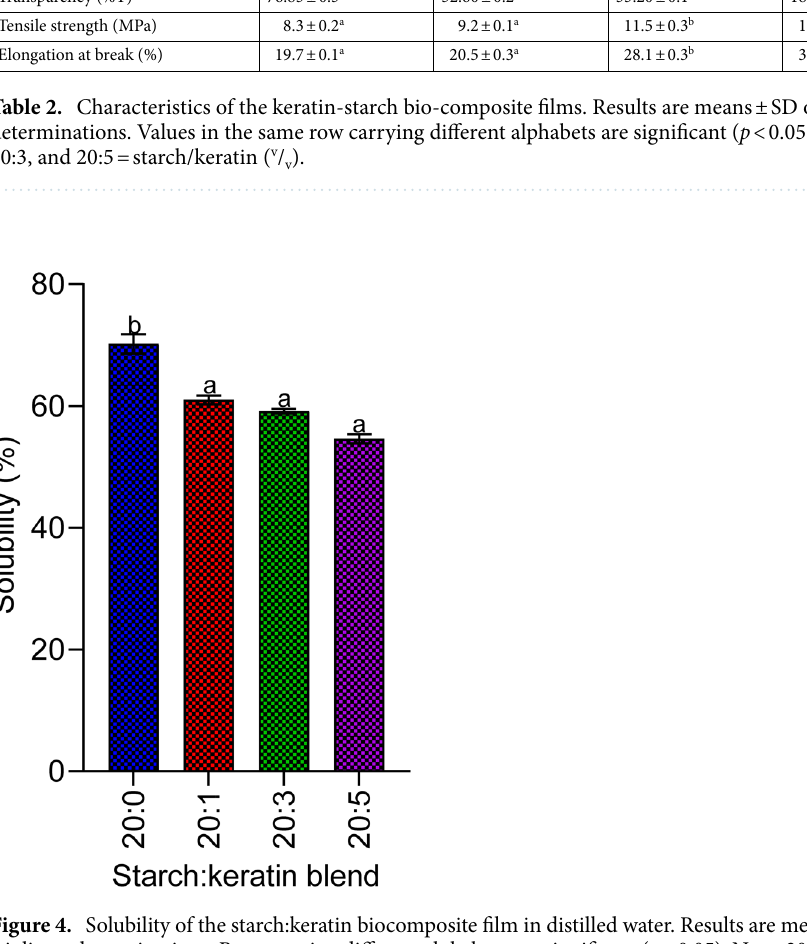
Figure 4. Solubility of the starch:keratin biocomposite film in distilled water. Results are means ± SD of triplicate determinations. Bars carrying different alphabets are significant ( p < 0.05). Note: 20:0, 20:1, 20:3, and 20:5 = starch/keratin ( v / v ). Chart was drawn using GraphPad prism 8.0 software (GraphPad Software Inc., San Diego, California), https:// www. graph pad. com/ scien tific- softw are/